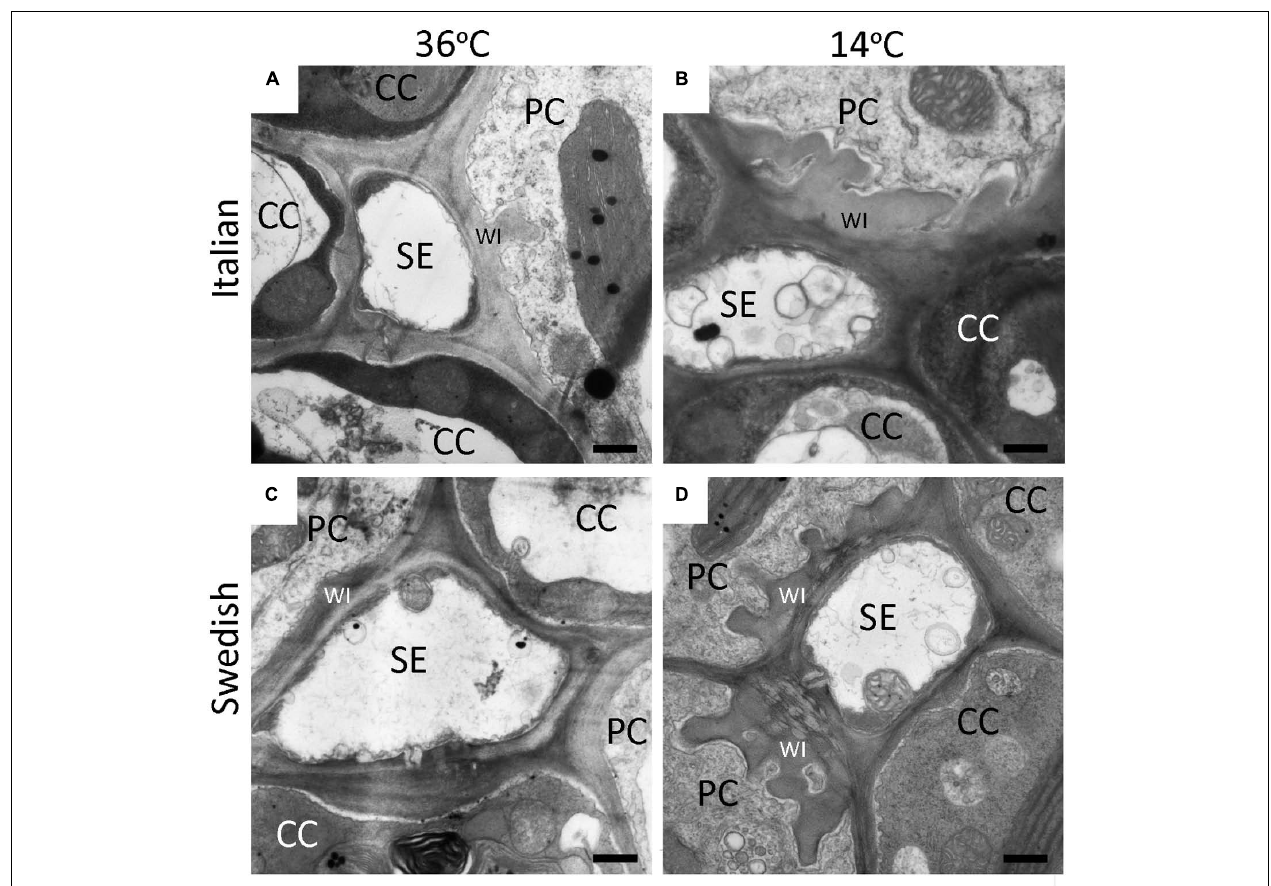
14 ◦ C (B,D). Cell-wall ingrowths (WI) in the PCs are adjacent to the area abutting a neighboring SE, sometimes extend over the area of adjacent CCs (particularly apparent at lower temperature), and are more pronounced (greater level of invagination) in both ecotypes that developed at lower temperature. Black bar = 500 nm in